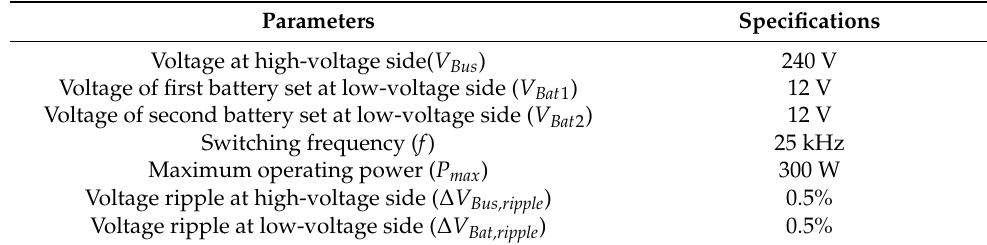
Table 2. The component parameters of the bidirectional buck–boost soft-switching converter.